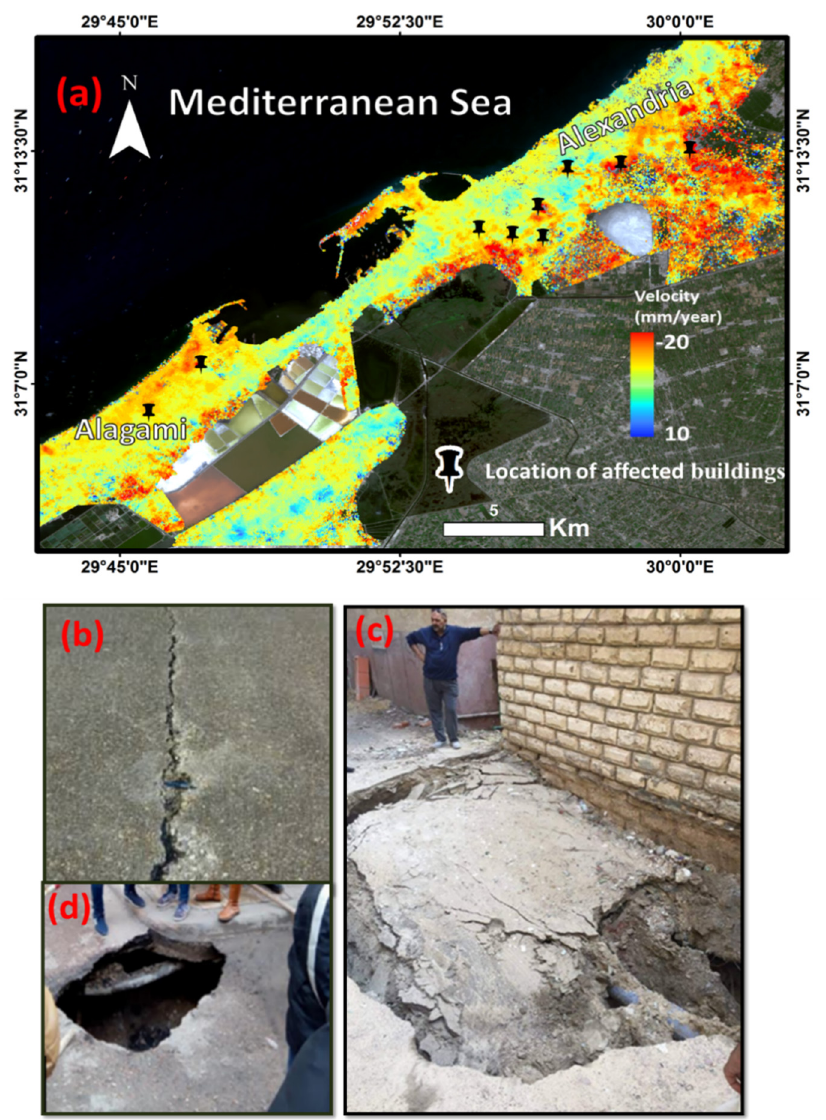
Figure 17. Land-Subsidence map shows the locations of the affected buildings ( a ); samples of cracks on roads and ground deformations located in high subsided areas ( b – d